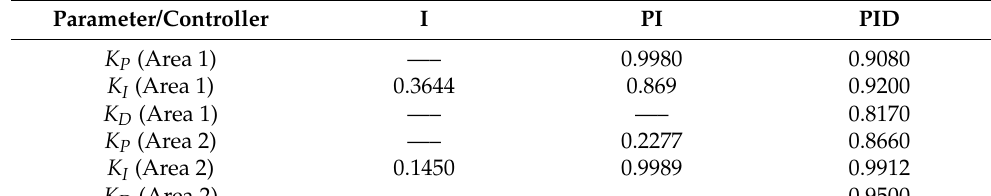
Table 1. The SAO-tuned I, PI, and PID controllers’ parameters.